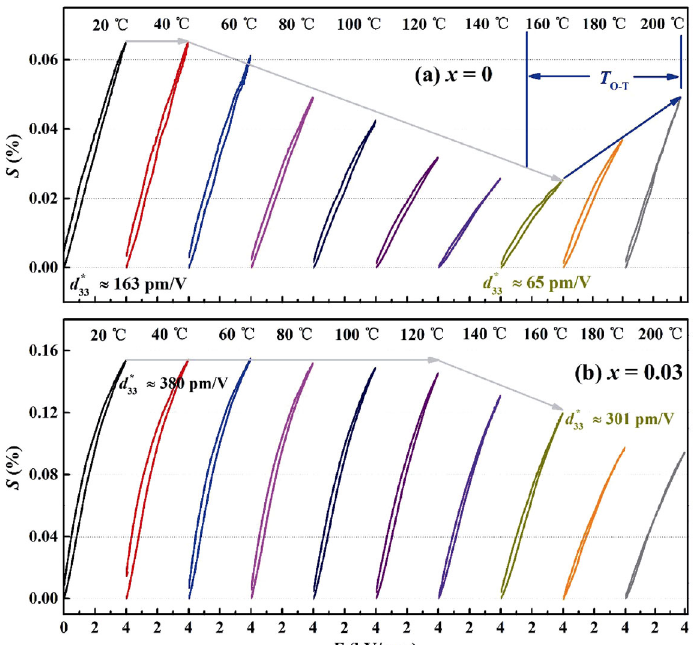
Fig. 9 Temperature dependence of unipolar S – E curves at a fixed electric field of 4 kV/mm for (a) x = 0 and (b) x = 0.03 ceramics.